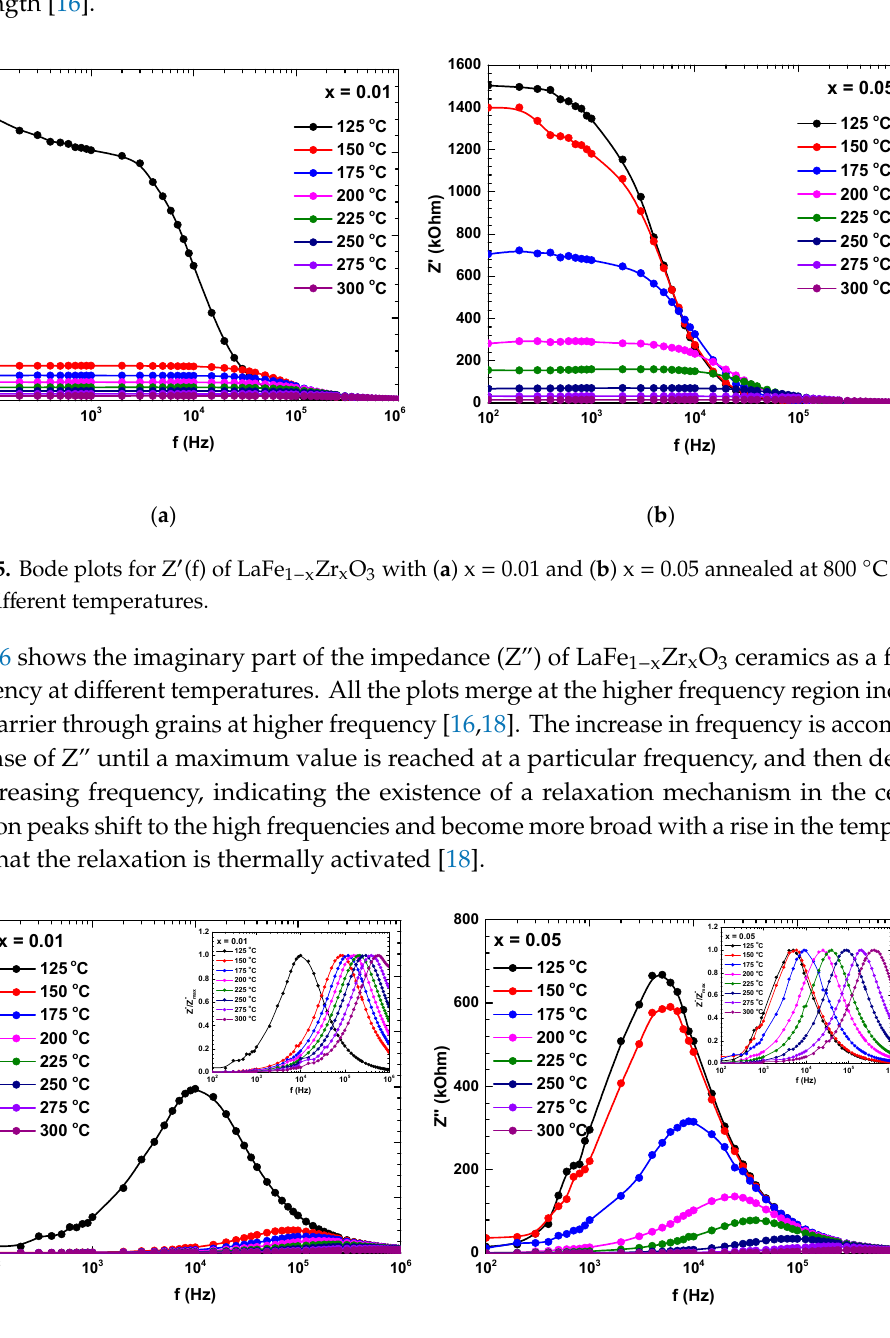
Figure 4. Nyquist plots of LaFe 1 − x Zr x O 3 with ( a ) x = 0.01 and ( b ) x = 0.05 annealed at 800 °C for 6 h at different temperatures.